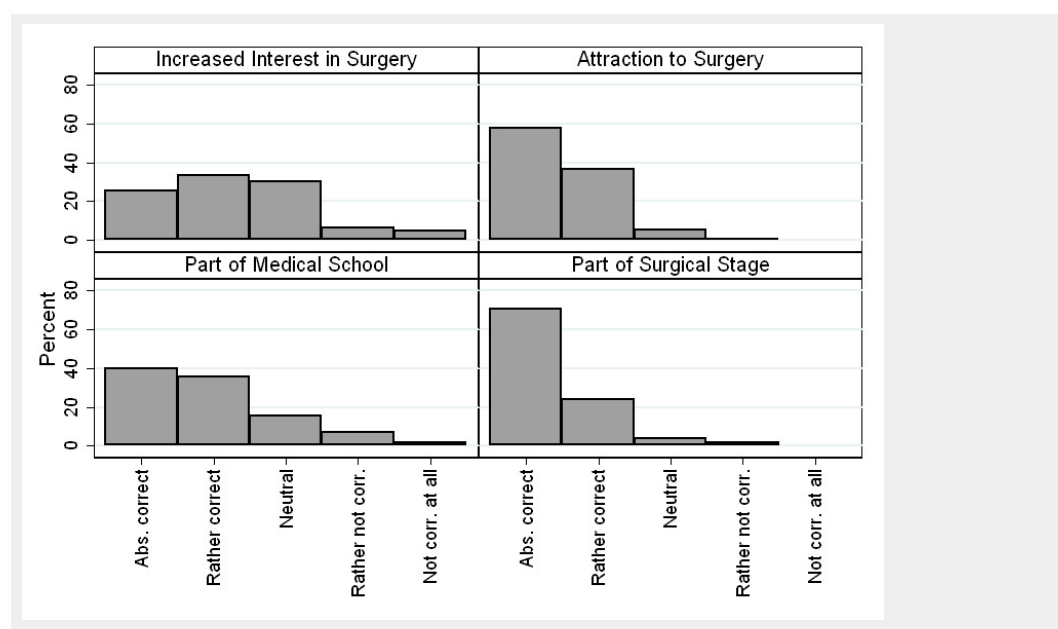
The following aspects apply to the virtual reality (VR) intervention in this study: The VR demonstration has increased my interest in surgery, the VR demonstration increased the attraction of surgery as a career choice, VR demonstrations and exercises should be a formal part of medical school, and the VR demonstrations and exercises should be integrated as formal part of the surgical stage. (Answering options with five descriptors: absolutely correct – rather correct – neutral – rather not correct – not correct at